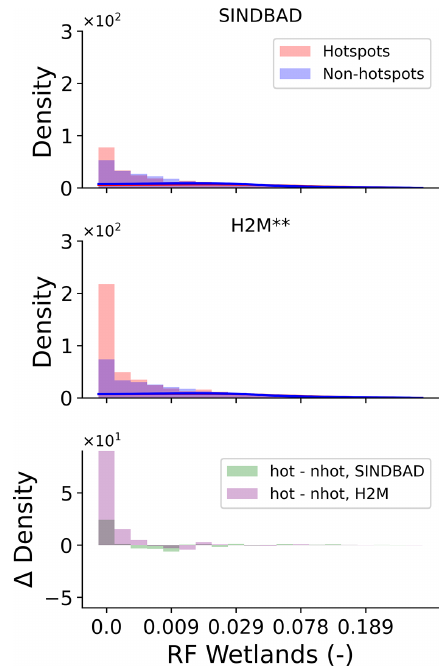
Figure B13. Same as Fig. 7 but for the fraction of regularly flooded (RF) wetlands provided by Tootchi et al. (2019).